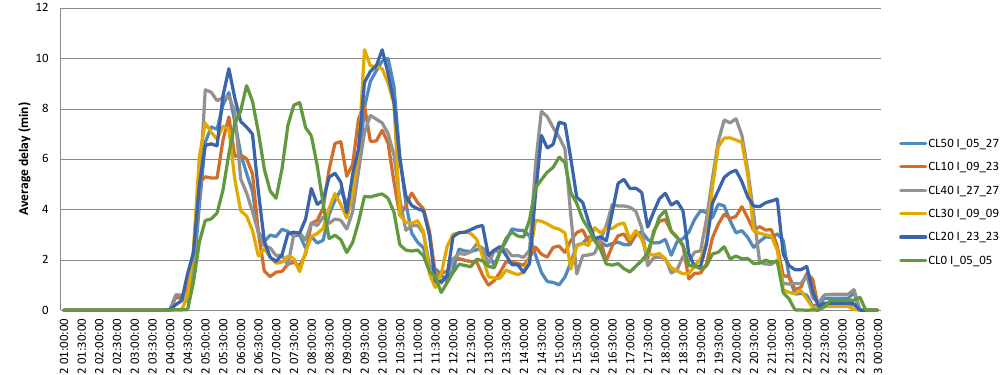
Figure 9. Comparison of saturation capacity average delay for each scenario .